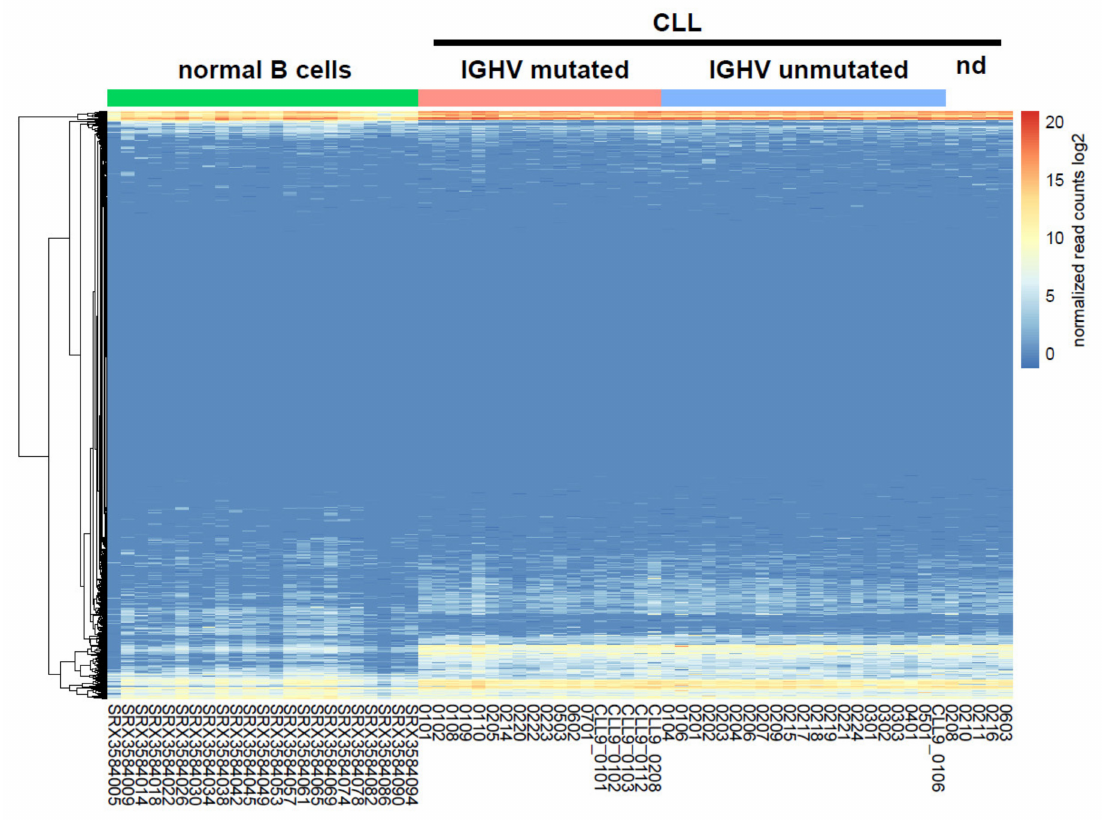
Figure 1. Gene expression profiles of miRNAs in CLL ( n = 44) and normal B cells ( n = 23). The heatmap indicates the expression values of individual miRNAs (listed on the y -axis) in the respective samples (listed on the x -axis). Significantly di ff erentially expressed miRNAs are summarized in Tables S1 and